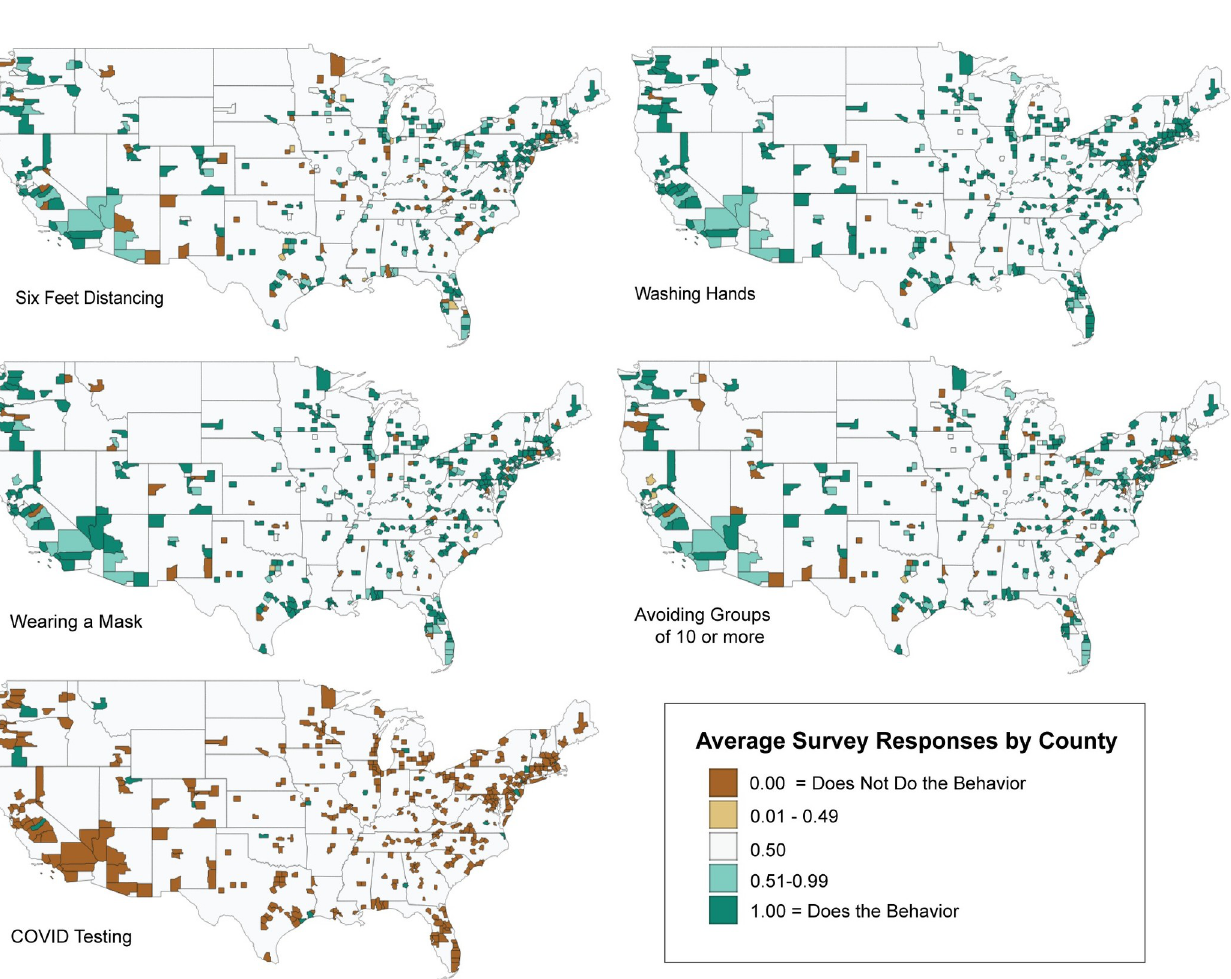
Fig 1. Average survey response by county for five COVID-19 prevention acts. Only counties with survey respondents in the continental US are shown. While survey responses were binary (Agree = 1, Does not agree = 0), results are averaged at the county-scale.